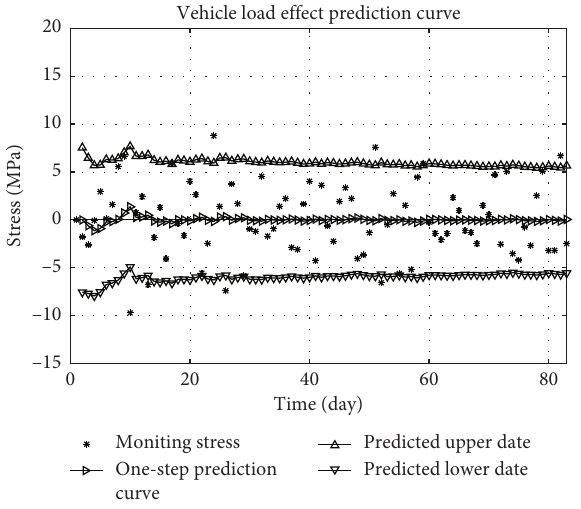
Figure 6: Predicted vehicle load effects.